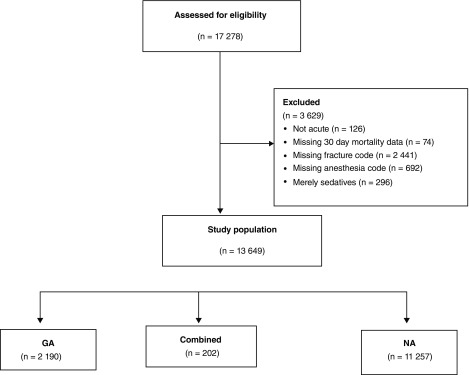
Study flow diagram displaying exclusions for the study cohort.